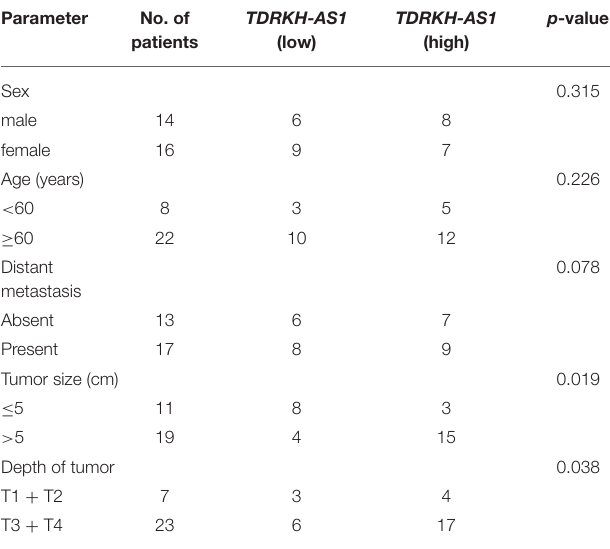
TABLE 1 | Relationships between TDRKH-AS1 expression and clinical pathological features of patients with colorectal cancer (CRC).